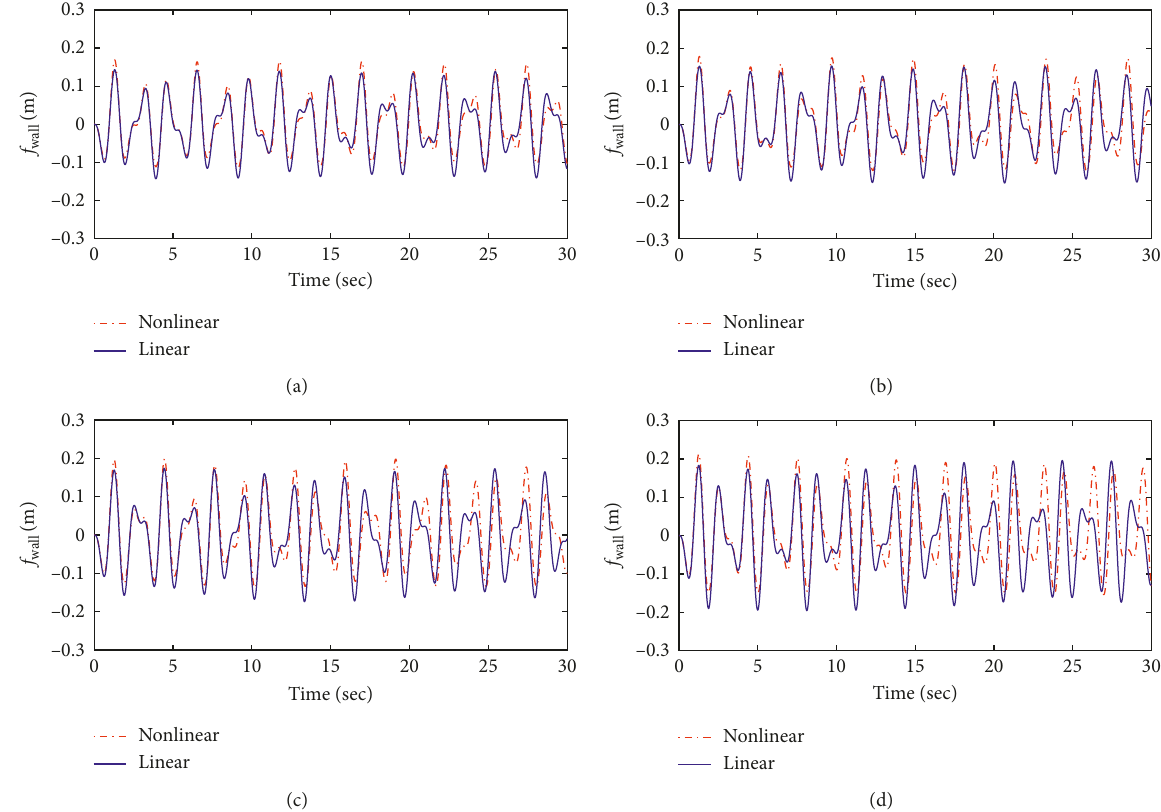
� 0.5m and r � 0 . 2 m 1 1